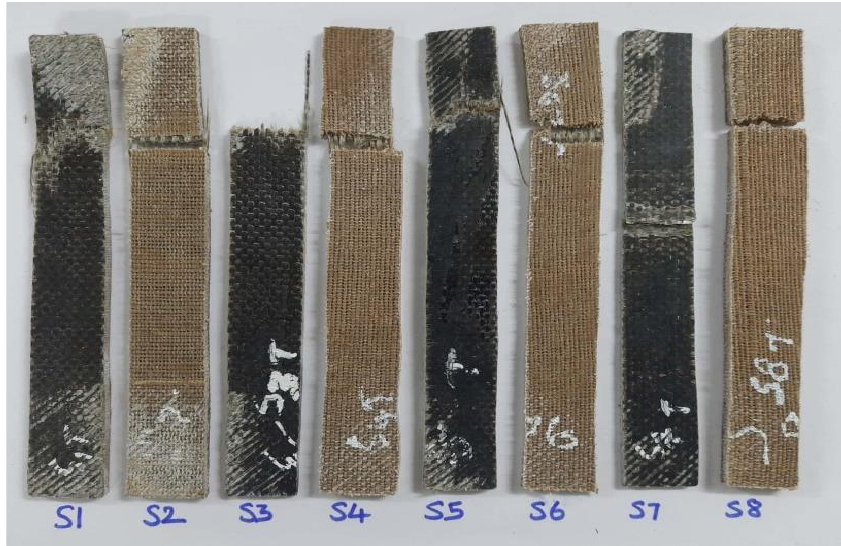
Figure 4. Tensile specimen after the test. (S1-BBBBBBBB; S2-RRRRRRR; S3-BBRRRBB; S4-RRBBBRR;